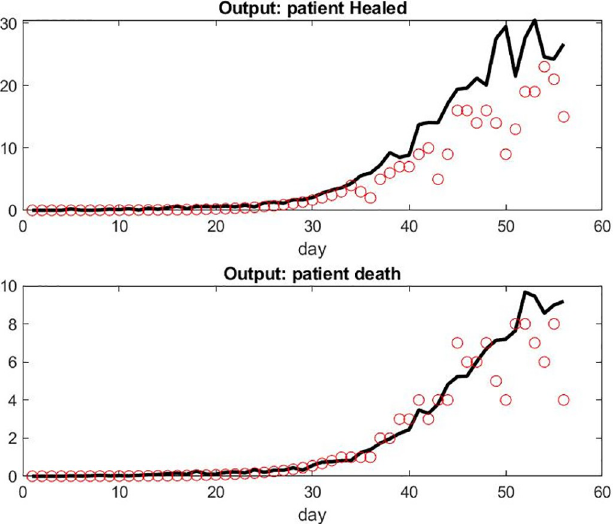
Fig 9. Top: Number of Patient Healed Leaving Hospital in Paris per Day. Bottom: Number of Death per Day.